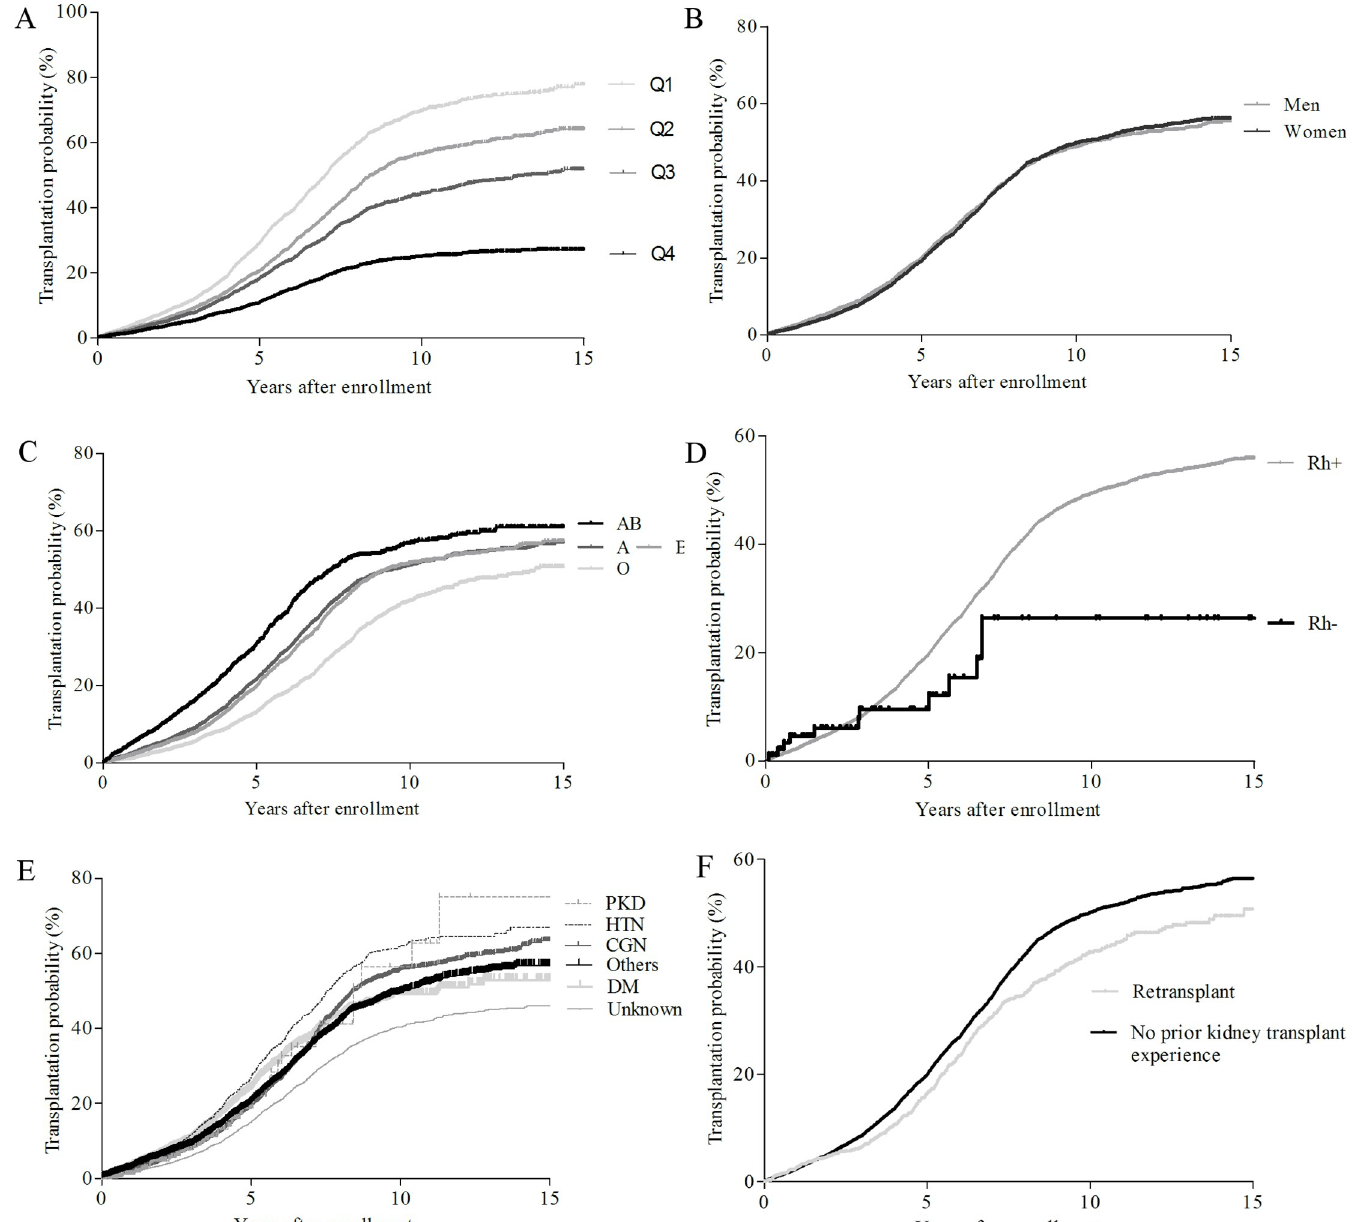
Fig 2. Cumulative probability to undergo deceased donor kidney transplantation on the waiting list according to age quartile (A), gender (B), ABO blood type (C), Rh blood type (D), cause of ESRD (E), and prior kidney transplant experience (F). Abbreviations: Q1, first quartile, age of 18 to 42; Q2, second quartile, age of 43 to 51; Q3, third quartile, age of 52 to 58; Q4, fourth quartile, age of 59 to 96; PKD, polycystic kidney disease; HTN, hypertension; CGN, chronic glomerulonephritis; DM, diabetic mellitus.